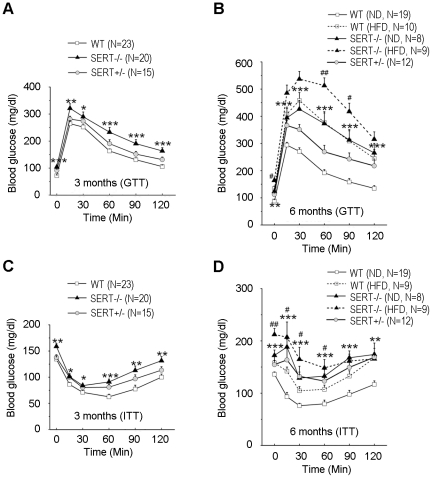
Characterization of glucose homeostasis in SERT-deficient mice.
A. GTT (i.p., 1 g/kg) of 3-month-old mice after 16 h fast. B. GTT (i.p., 1 g/kg) of 6-month-old mice after 16 h fast. C. ITT (i.p., 1 U/kg) of 3-month-old mice after 6 h fast. D. ITT (i.p., 1 U/kg) of 6-month-old mice after 6 h fast. N, number of mice analyzed for each genotype. Data represent mean ± SEM. Student's t-test was used to analyze statistical significance of the difference between the following groups: SERT−/− vs. WT mice on ND feeding, *p<0.05, **p<0.01, ***p<0.001; SERT−/− vs. WT mice on HFD feeding, #p<0.05, ##p<0.01, Student's t-test. At 3 months of age, the differences in GTT of SERT+/− vs. WT mice were not statistically significant; however, there were significant differences between SERT+/− vs. WT mice in ITT. At 6 months of age, both SERT−/− and SERT+/− mice differed significantly from WT mice in GTT and ITT.